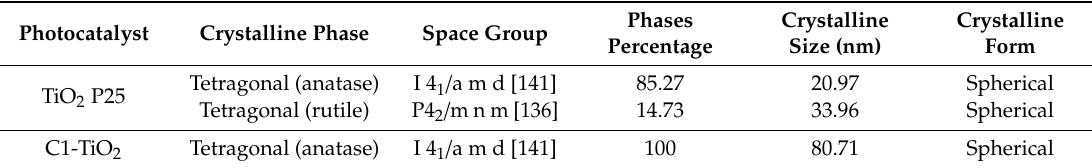
Table 1. Crystallographic properties of TiO 2 P25 and C1-TiO 2 through